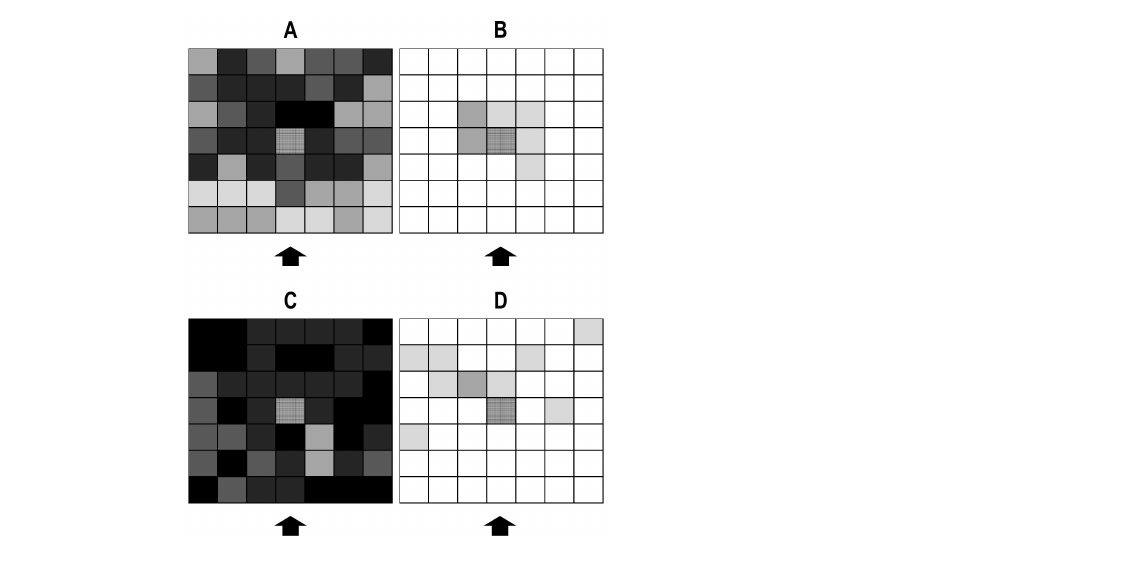
Figure 5. Distribution of melon powdery mildew infection spread by conidial scatter from a single KNP-6N-inoculated melon seedling to surrounding healthy melon seedlings under continuous